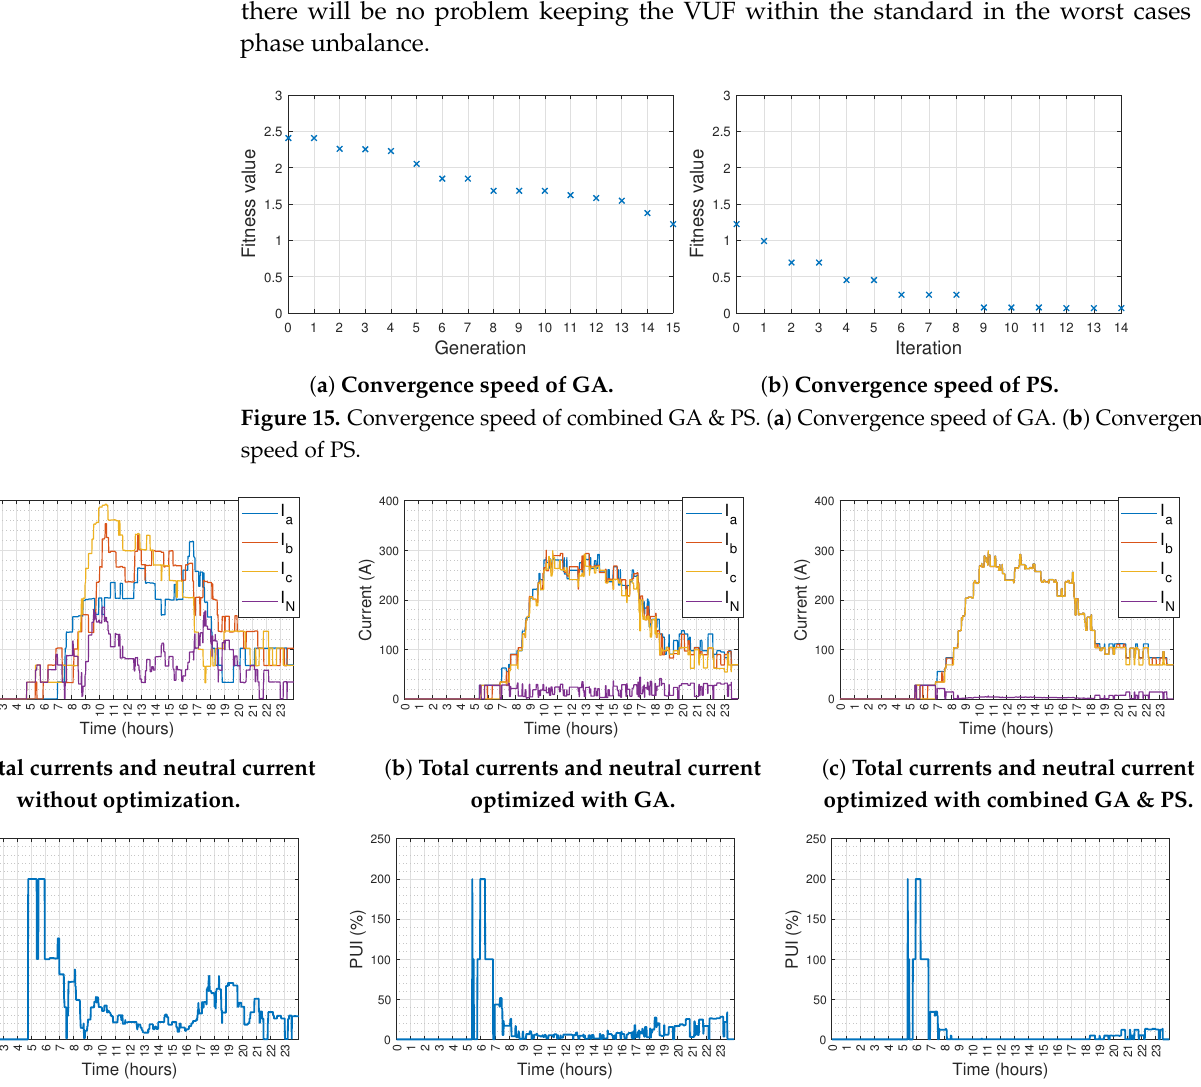
Figure 16. Total currents, neutral current, and the PUI for three cases. ( a ) Total currents and neutral current without optimization. ( b ) Total currents and neutral current optimized with GA. ( c ) Total currents and neutral current optimized with combined GA and PS. ( d ) PUI without optimization. ( e ) PUI optimized with GA. ( f ) PUI optimized with combined GA and